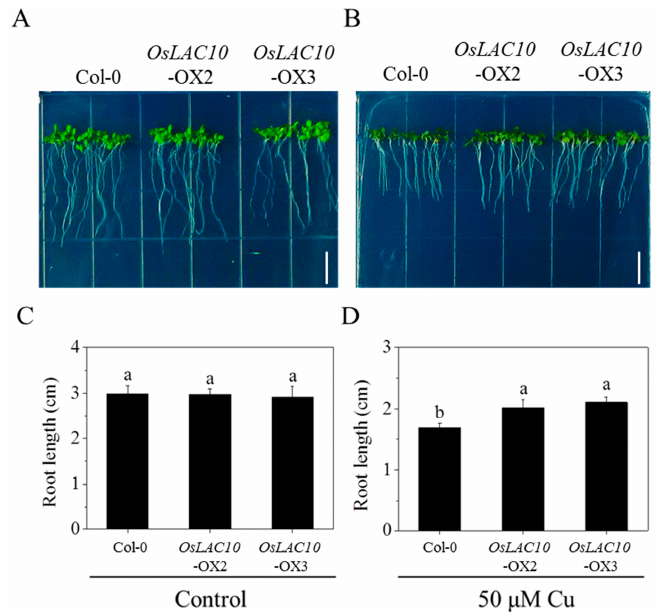
Figure 8. Effect of Cu stress on growth of wild-type and OsLAC10 transgenic Arabidopsis on 1/2 Murashige and Skoog (MS) medium. ( A , B ) Growth phenotypes of wild-type and OsLAC10 transgenic Arabidopsis under normal conditions and Cu (50 µ M) stress, respectively, white bars, 1 cm; ( C , D ) Changes in root length of wild-type or OsLAC10 transgenic Arabidopsis under control conditions and Cu (50 µ M) stress, respectively. The data are the means ± SD ( n = 8). Different letters (a, b) above the column indicate a significant difference at p < 0.05 according to the LSD tests.